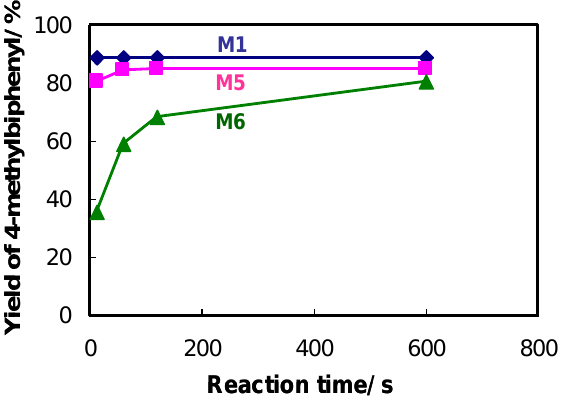
Figure 5. Effect of ligands on the reaction of bromobenzene with 4-methylphenylboronic acid. Other conditions were similar to those in Figure 3.